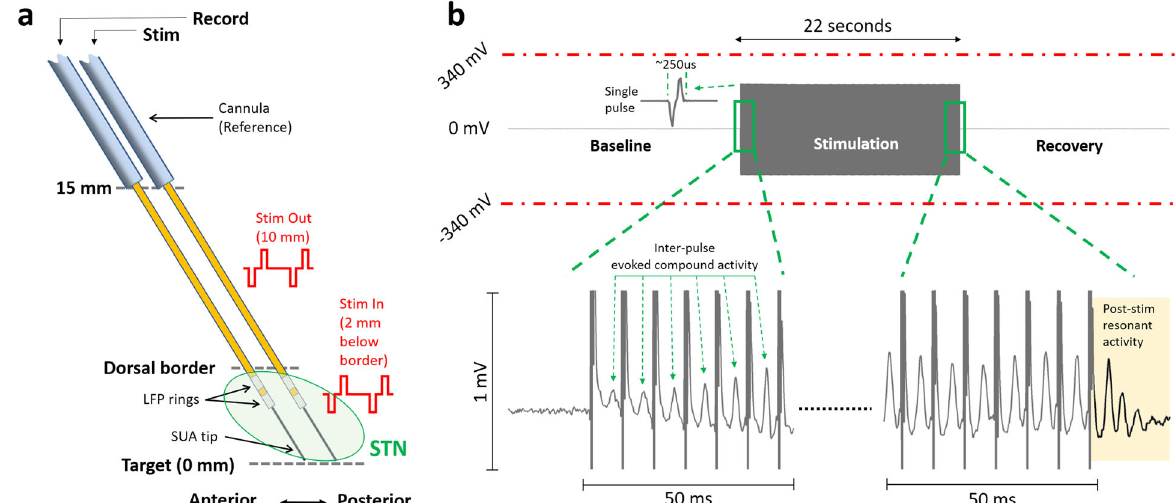
Fig. 1 Experimental paradigm and sample stimulation segment showing that LFP recordings did not saturate with the high input range of the ampli fi er. a The microelectrode diagrams depicting the recording and stimulating electrodes. The “ out-STN ” stimulation was performed 10 mm above the ventral border of the STN. Bipolar microelectrodes with two 0.5-mm wide stainless-steel rings separated by 0.5 mm were used to deliver biphasic electrical stimulation and record LFP activity. The “ in-STN ” stimulation experiments were performed 2 mm below the dorsal border of the STN, characterized by the increased background activity and neuronal spiking recorded from the fi ne microelectrode tip. b Sample 66 s raw LFP recording illustrates that the ampli fi er was not saturated during stimulation of the other electrode. Single pulse waveform illustrates that the biphasic stimulation pulse was captured within a short time, allowing the LFP recordings to continue with minimal interruption. Zoomed 50 ms segments from beginning and the end shows evoked potentials induced with each stimulus pulse. The evoked waveform amplitude increases with each pulse and settles after ~10 pulses. With the termination of the stimulation, the resonance in the evoked activity can be observed longer, which dampens within 20